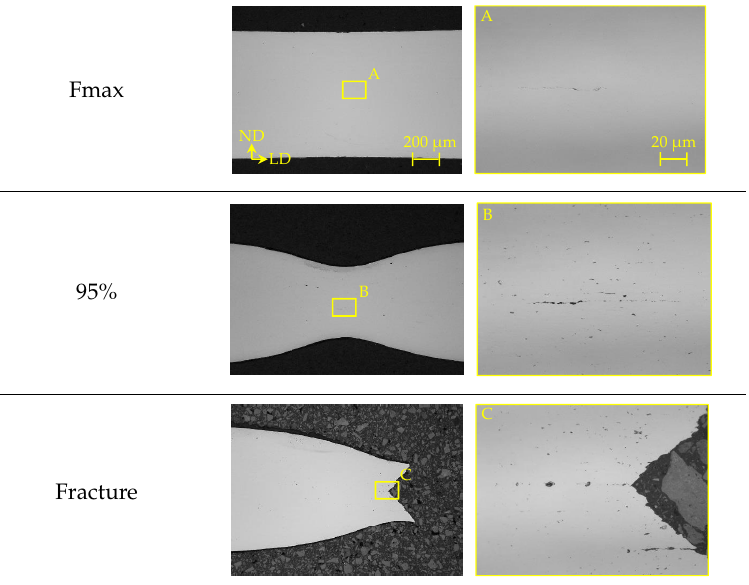
Table A15. Damage evolution of DP1000.